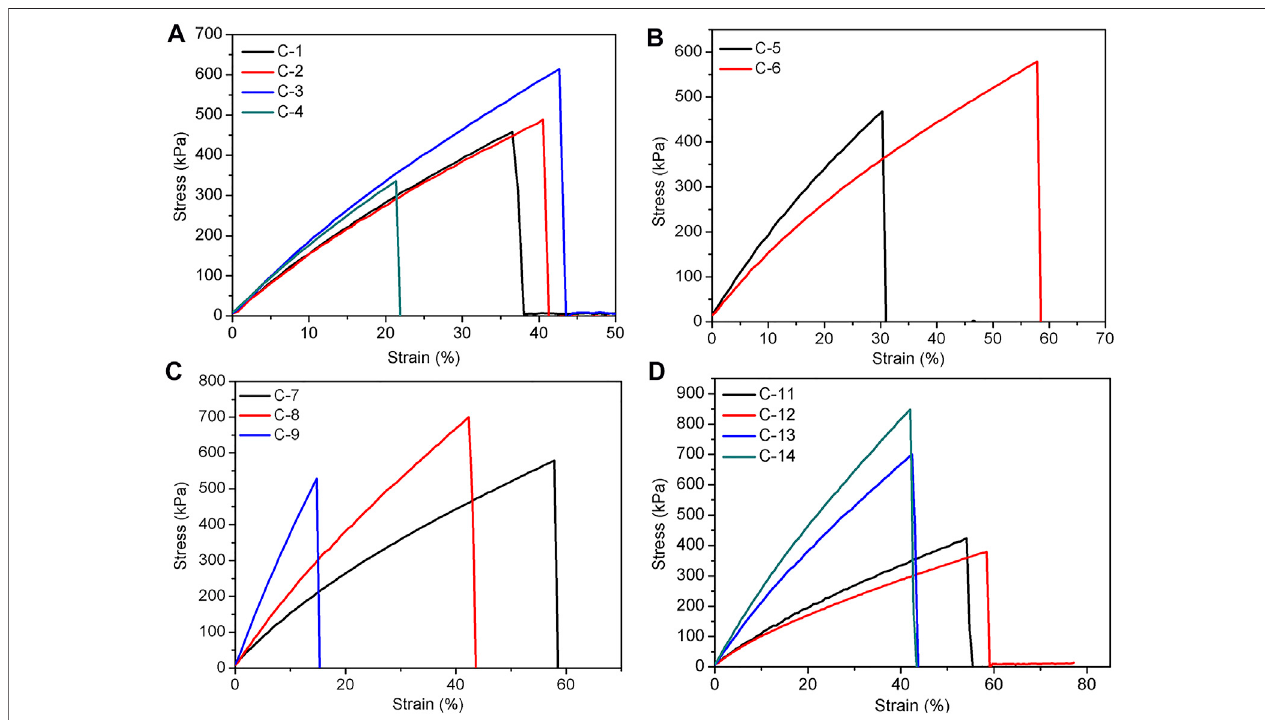
FIGURE 4 | The tensile curves of covalently bonded elastomers in fl uenced by heating time (A) , DP-1 (B) , -NH 2 content (C) , and TA content (D) .